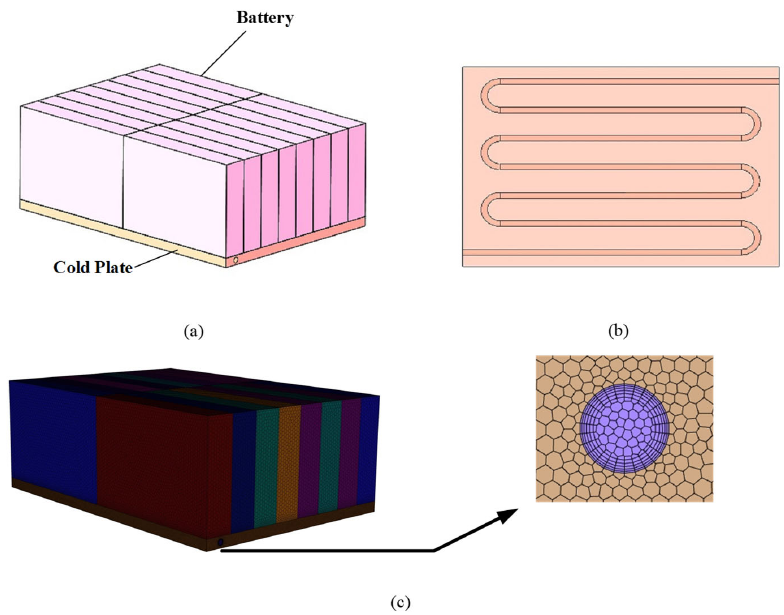
Figure 3. ( a ) Structure of the battery module with thermal management; ( b ) structure of the cold plate; ( c ) display of the